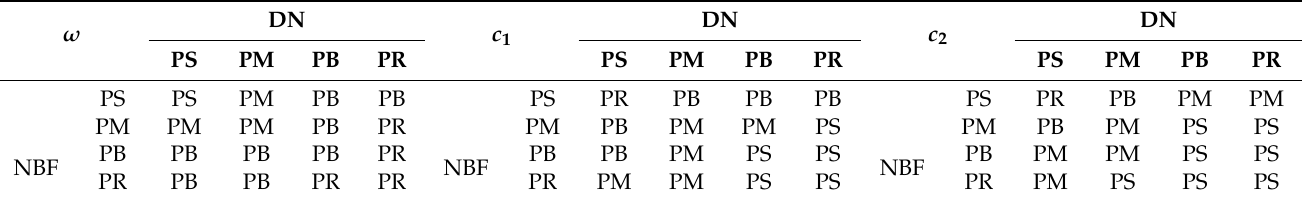
Table 1. Fuzzy rules for inertia weight ω , learning factor c 1 and c 2